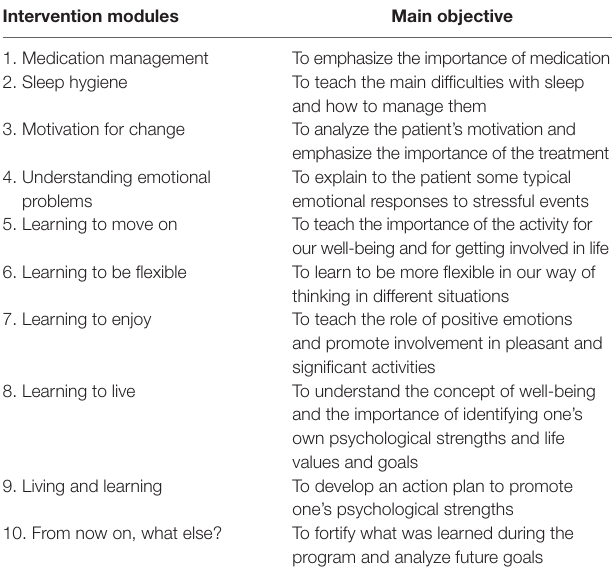
TABLE 1 | Intervention modules and main